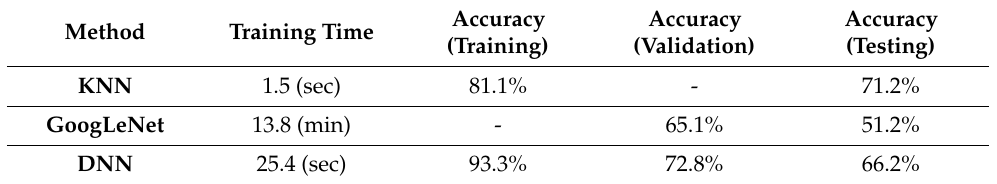
Table 7. Comparison of accuracy between KNN, GoogLeNet, and the original method of this research.